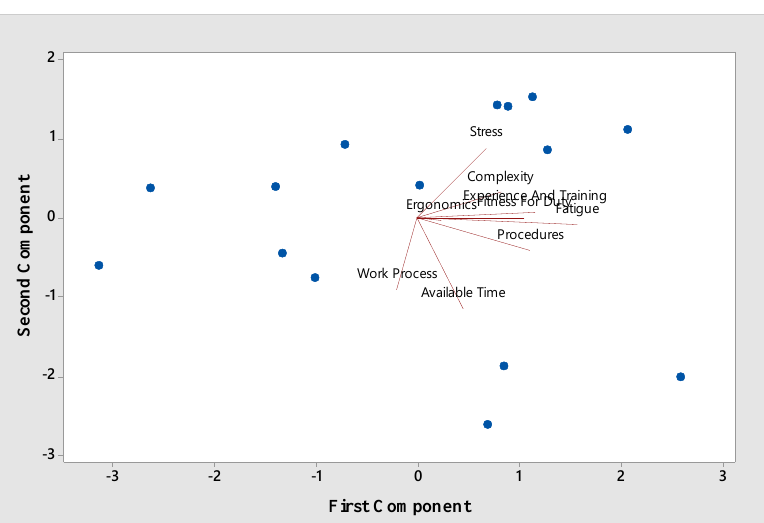
Fig. 2. The relation between